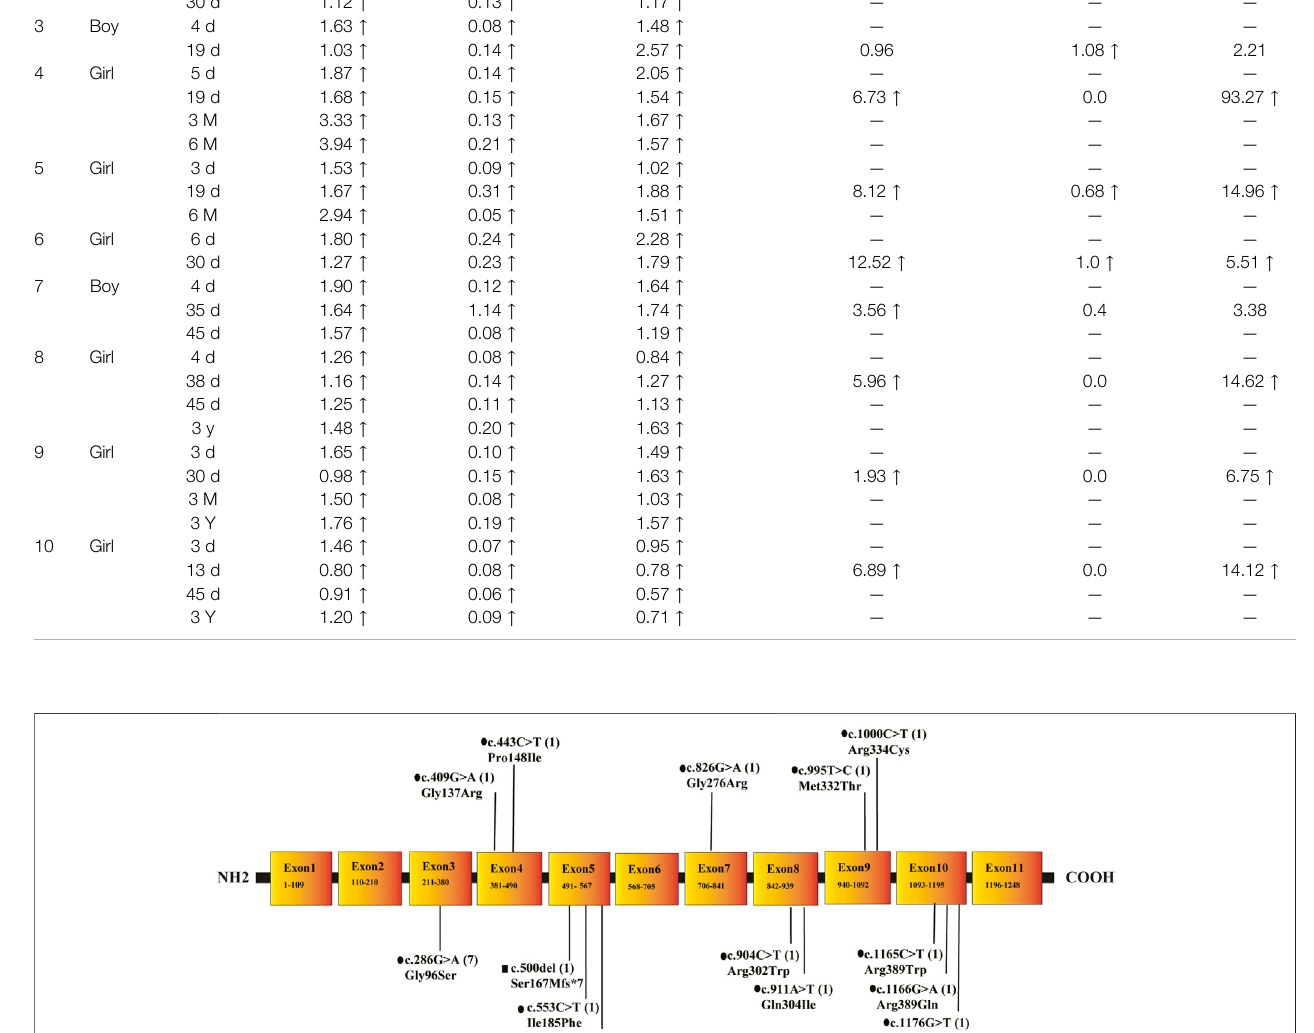
FIGURE2| Thelocation,typeandfrequencyof ACAD8 mutationsin10patientswithIBD.Note: